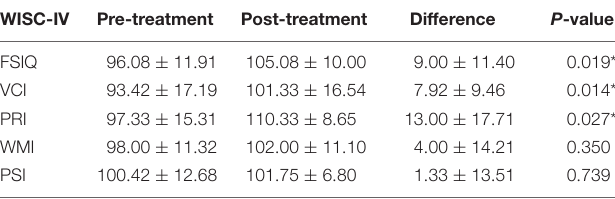
TABLE 2 | WISC-IV scores before and after